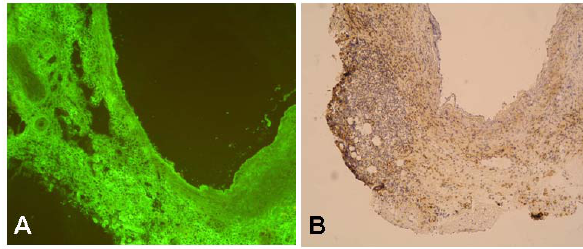
Figure 4. Histological features of rejected non-immunosup- pressed alloveins. Representative light microscopic photograph showing the histological features of alloveins in non-immunosup- pressed rats (group B) 30 days following transplantation into the infrarenal abdominal aorta: A - vein stained for immunoglobulins with a fluorescein isothiocyanate-conjugated antibody (Chemicon Internation- al Inc, Temecula, California, USA). No free clusters of immunoglobulins were detected in the allovenous wall. B - vein stained for CD4 + cells with anti-CD4 antibody (OX-8, Cymbus Biotechnology LTD, South- ampton, UK) as described previously.[12] Massive infiltration of CD4 + immunocompetent cells (stained brown) led to the destruction of allovenous wall with no histological signs of arterialisation. Original magnification 6 100.